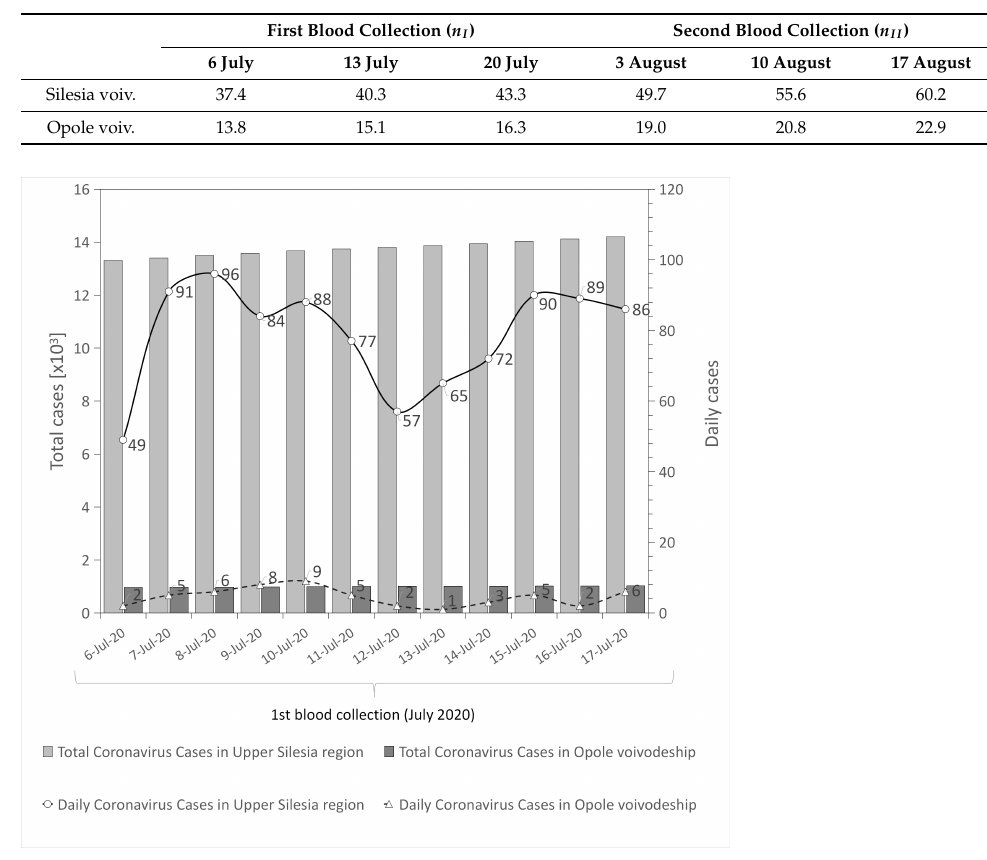
Figure 2. Number of infected individuals in both regions during 1st blood collection ( n I , July 2020)